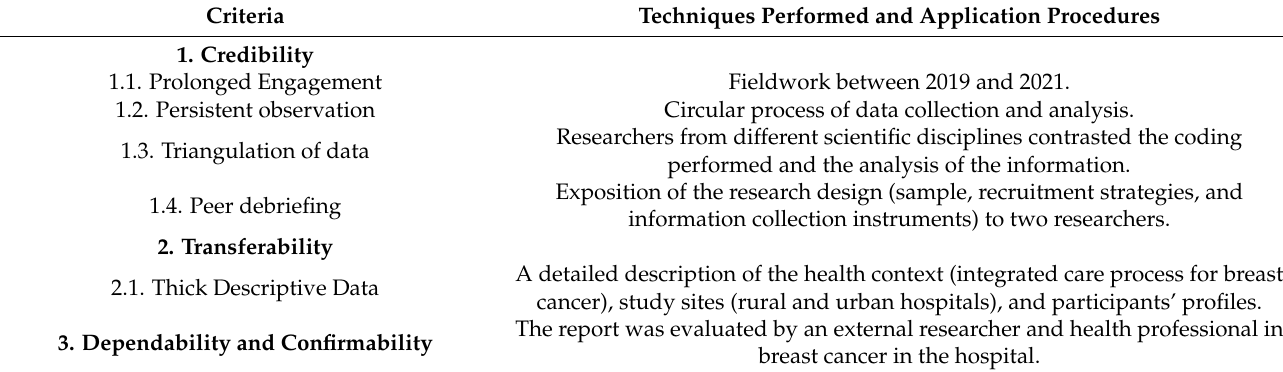
Table 3. Scientific Rigor